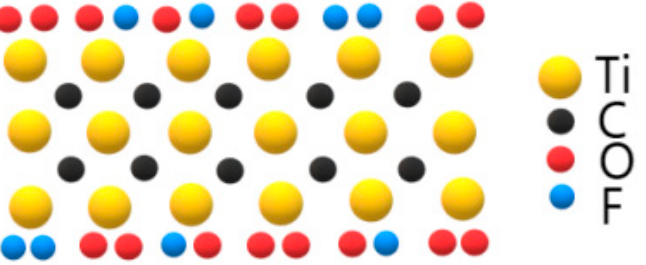
Figure 9. Schematic structure of Ti 3 C 2 T x MXene.